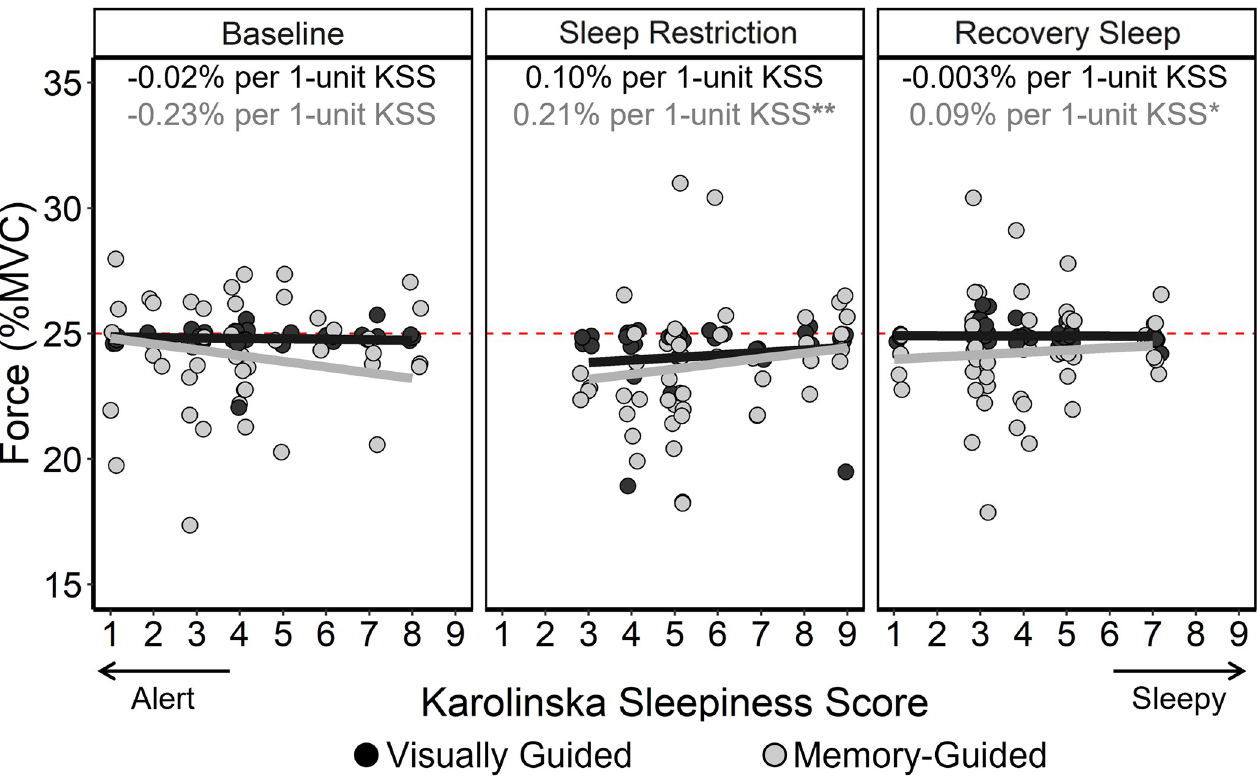
Fig 4. Force production by day and vision condition as a percentage of maximum voluntary contraction (MVC), as related to Karolinska Sleepiness Scale (KSS) score. The red dashed line indicates the target force (25% MVC). The black circles and lines indicate the visually guided condition, and the grey points and lines indicate the memory-guided condition. Each circle indicates a participants’ average force during each trial (4 trials per vision condition). Lines indicate the relationship between KSS score and force relative to MVC. Asterisks indicate difference in slopes between baseline and the respective day. �� p < 0.01; � p <